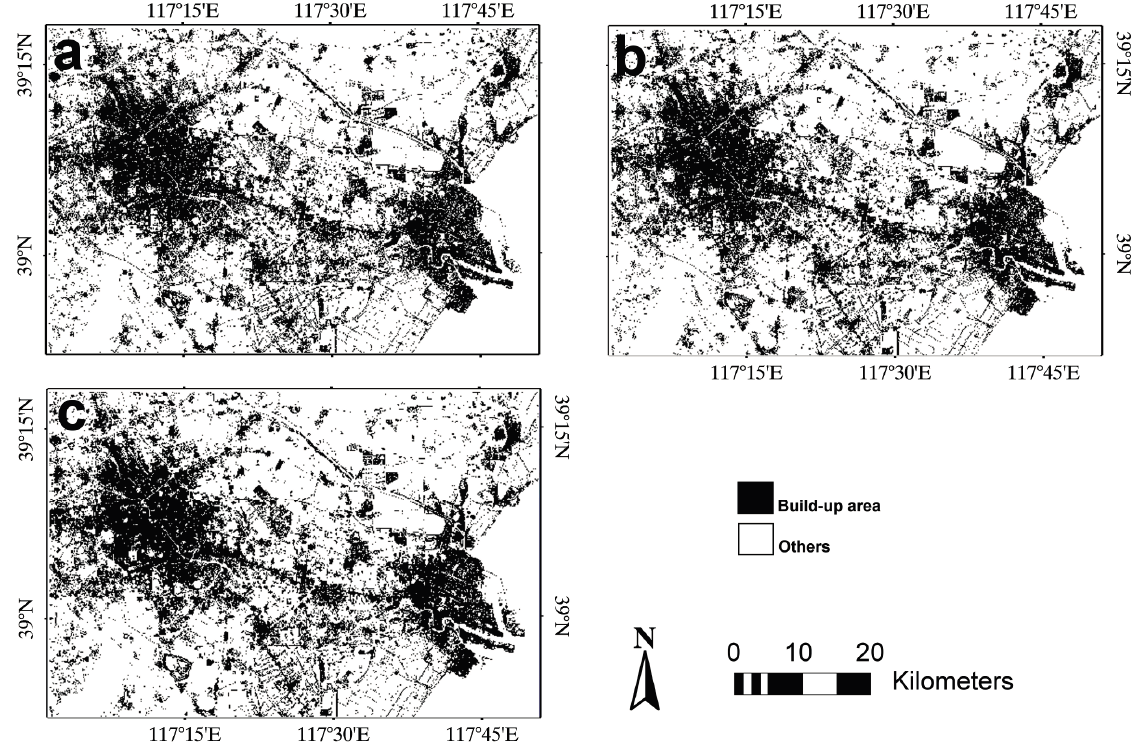
Figure 8. Classification results of the 2006 Tianjin image using spectral information alone ( a ); using spectral information and one-band texture ( b ); using spectral information and multivariate variogram texture with spectral angle distance ( c